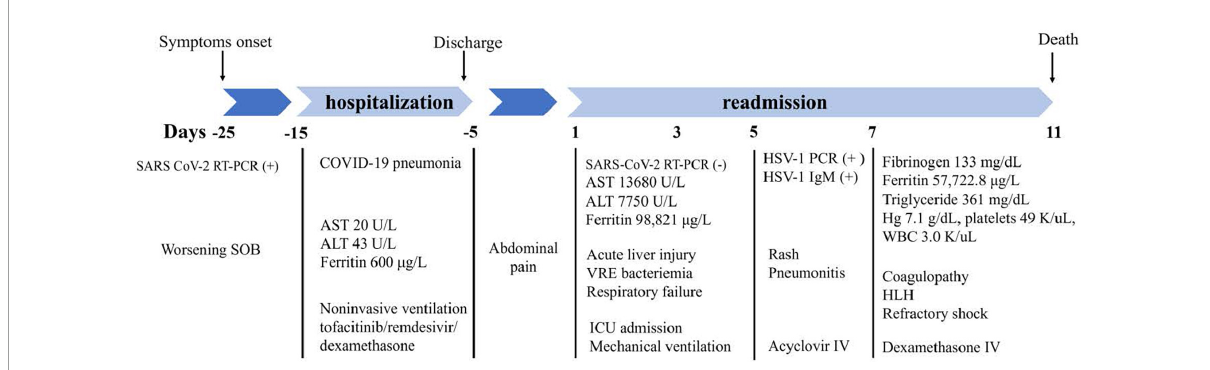
FIGURE3 Flow chart of significant clinical events and outcomes. SARS, severe acute respiratory syndrome; COVID-19, coronavirus disease 2019; RT-PCR, reverse transcriptase polymerase chain reaction; SOB, shortness of breath; AST, aspartate transaminase; ALT, alanine transaminase; VRE, vancomycin resistant enterococcus; ICU, intensive care unit; HSV-1, herpes simplex virus 1; IV, intravenous; Hg, hemoglobin; WBC, white blood cells; HLH, hemophagocytic